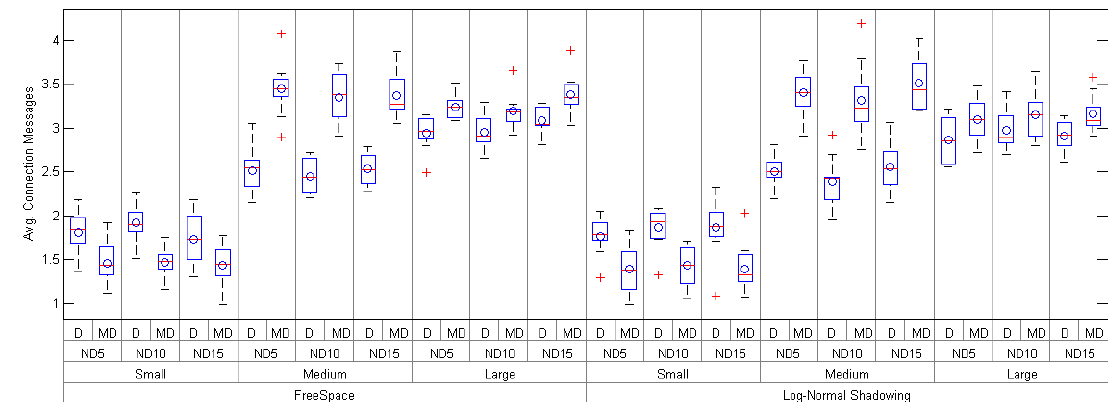
Figure 6. Average number of control messages of Daral (D) and mDaral (MD) for small-, medium- and large-size scenarios under different propagation conditions and node densities (ND5, ND10 and ND15). Table 4. Average battery consumed during the network set-up for small-, medium- and large-size scenarios under different propagation conditions. ND and PM stand for Node Density and Propagation Model